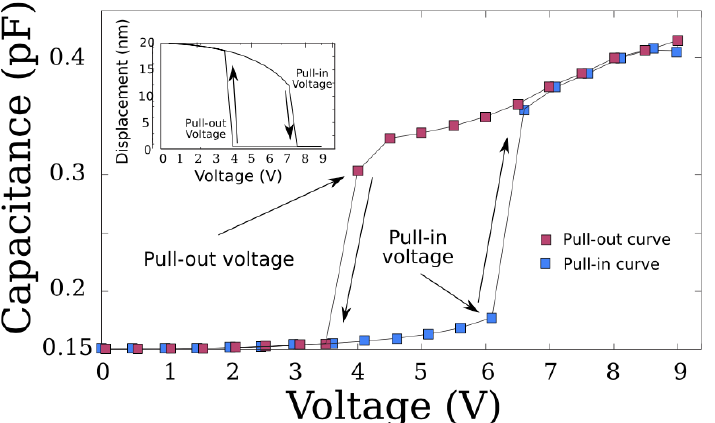
Figure 5. Set of curves obtained using numerical analysis. Here, the hysteresis cycle shows the trajectories of the pull–in and pull–out voltages for the double-plate capacitor model.